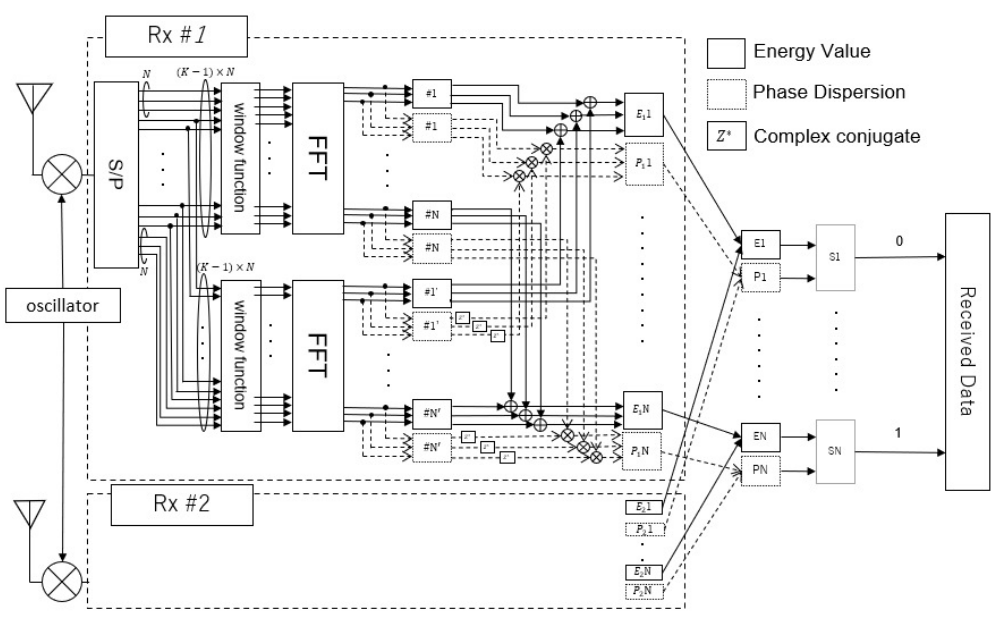
Figure 8. Receiver-side processing.